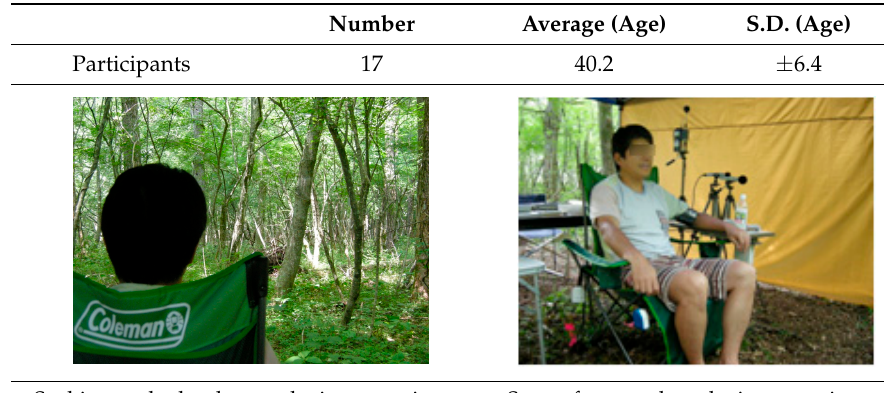
Table 3. Information on respondents.